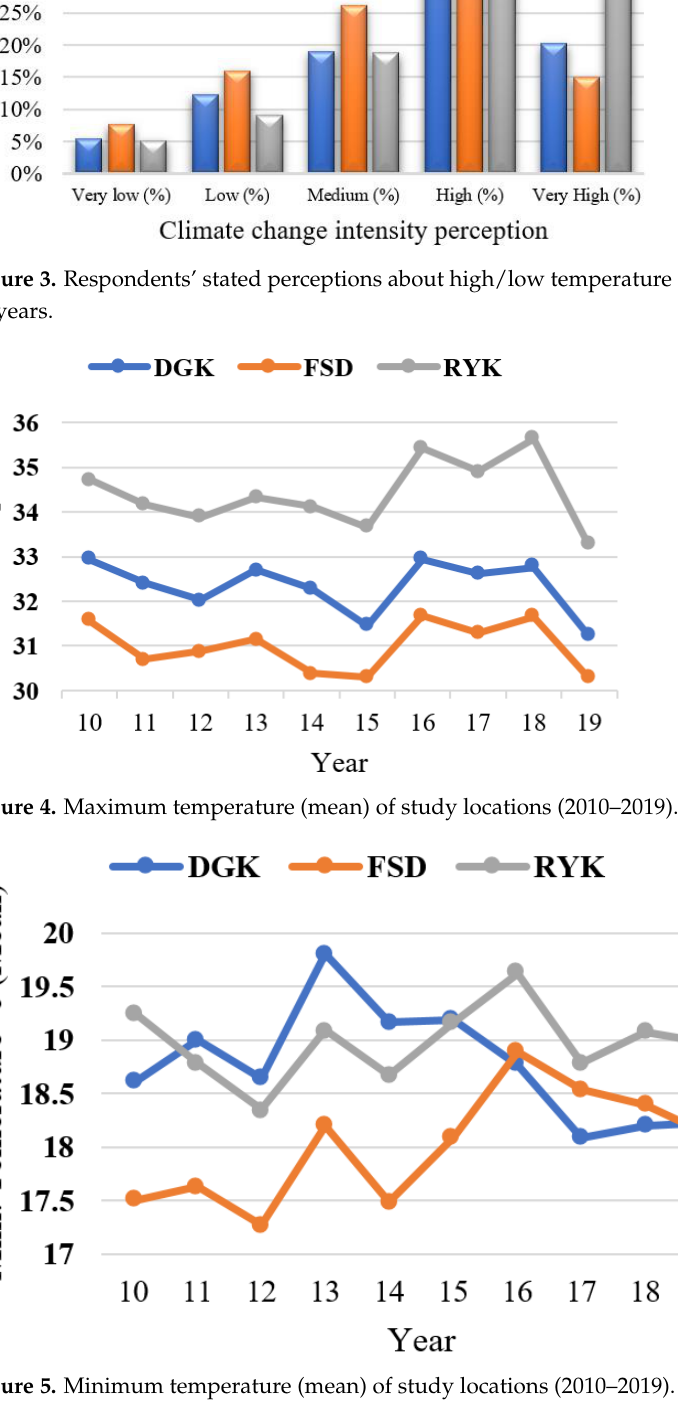
Figure 6. Annual rainfall in the study locations (2010–2019). The specific climate-related characteristics of the selected agro-ecological zones for the period 2010–2019 were derived from the processing of meteorological data. The results show that, from 2010 to 2019, the annual minimum/maximum temperature (mean) of DGK, RYK, and FSD were 18.77/32.34, 18.98/34.41, and 18.01/30.99, respectively. The an- nual rainfall from 2010 to 2019 of DGK, RYK, and FSD was 248.98, 143.43, and 434 mm, respectively. Consequently, these zones were characterized by a mean annual tempera- ture in the range of around 18.6–32.6 °C, and total annual rainfall in the range of 143 to 434 mm, during the study period. 3.3. Contributing Factors of Vulnerability 3.3.1. Exposure Assessment Exposure is considered to be a major dimension of vulnerability, and refers to changes in key variables of the climatic system (e.g., precipitation and temperature) and extreme events (drought, flood, and animal diseases). In the present research, the expo- sure assessment was based on respondents’ perceptions and was compared with the re- gional climatic data (rainfall, minimum temperature, maximum temperature) provided by the Pakistan meteorological department (PMD). Within exposure, two major compo- nents were categorized into nine sub-components (Table 4): extreme events (defined as